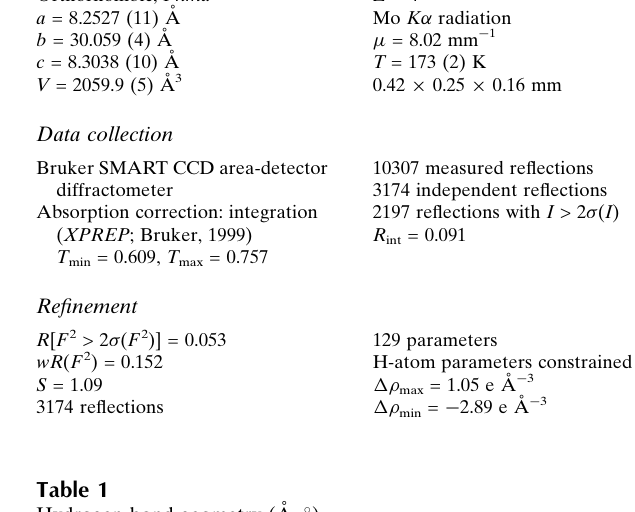
Hydrogen-bond geometry (A˚ , (cid:4)